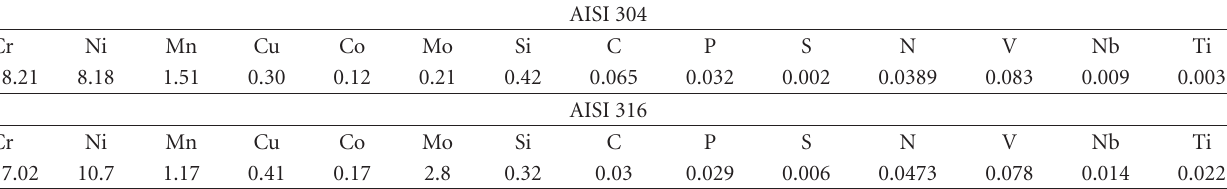
Table 1: The chemical composition of the stainless steel used as metal base.